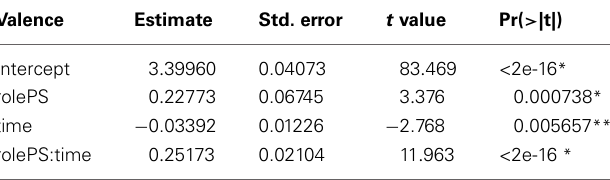
Table 2 | Coefficients for OLS regression for Valence